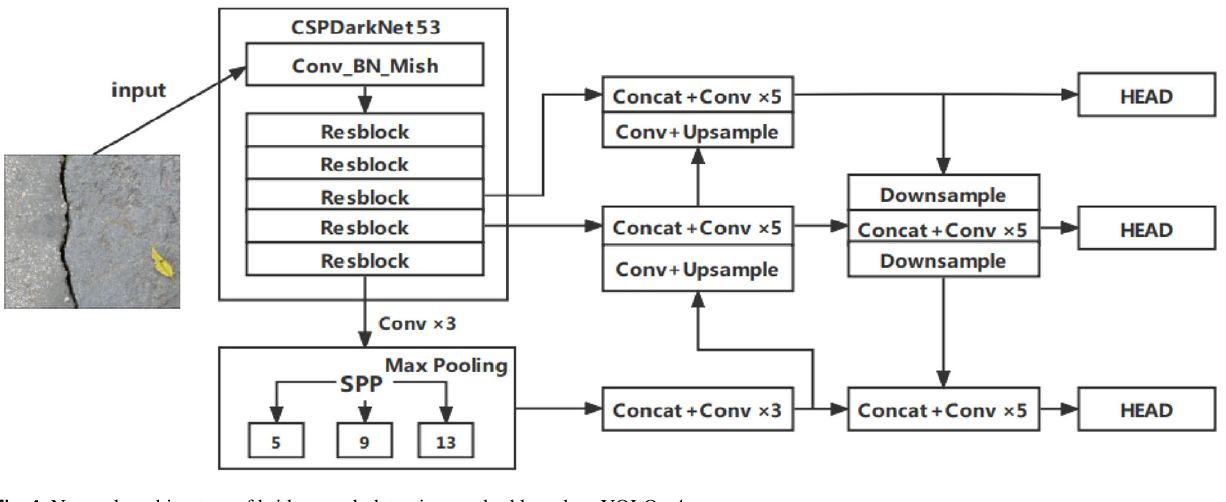
Fig. 4 Network architecture of bridge crack detection method based on YOLO v4